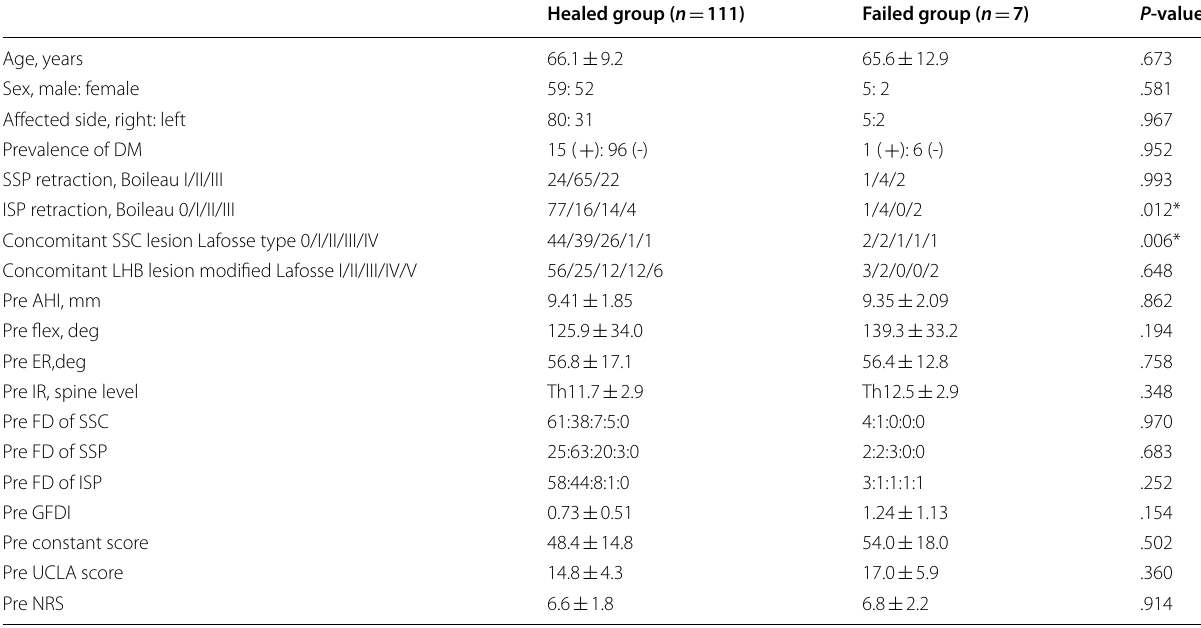
* Statistically significant between the healed and failed groups ( p < 0.05)